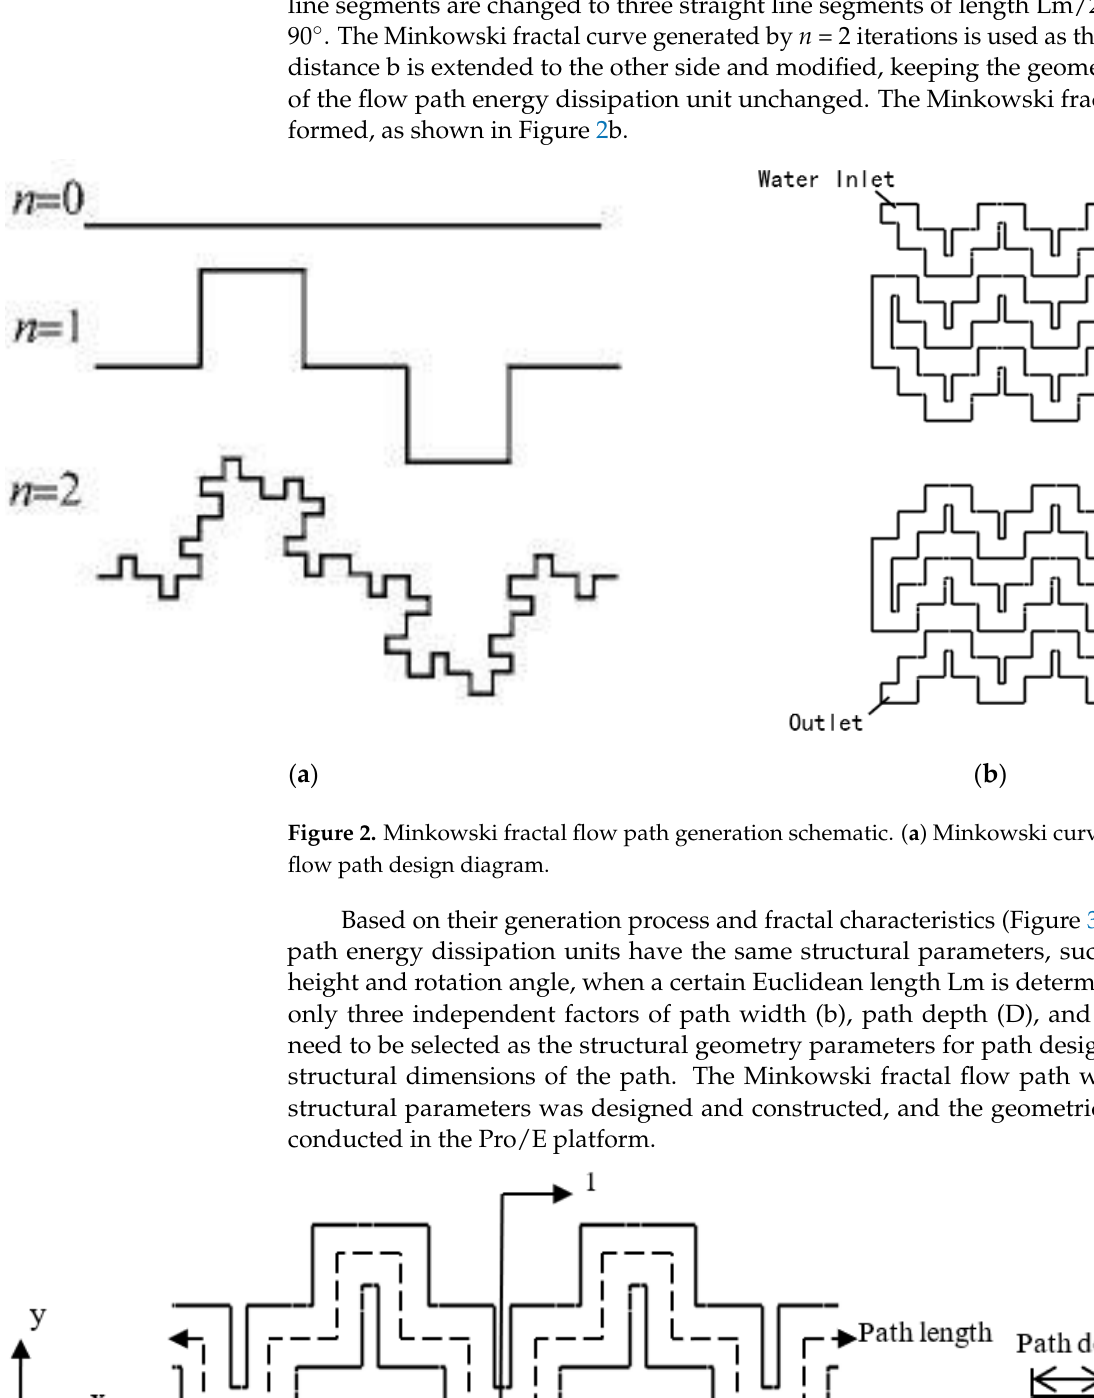
Figure 3. Minkowski schematic diagram of flow path structure parameters.